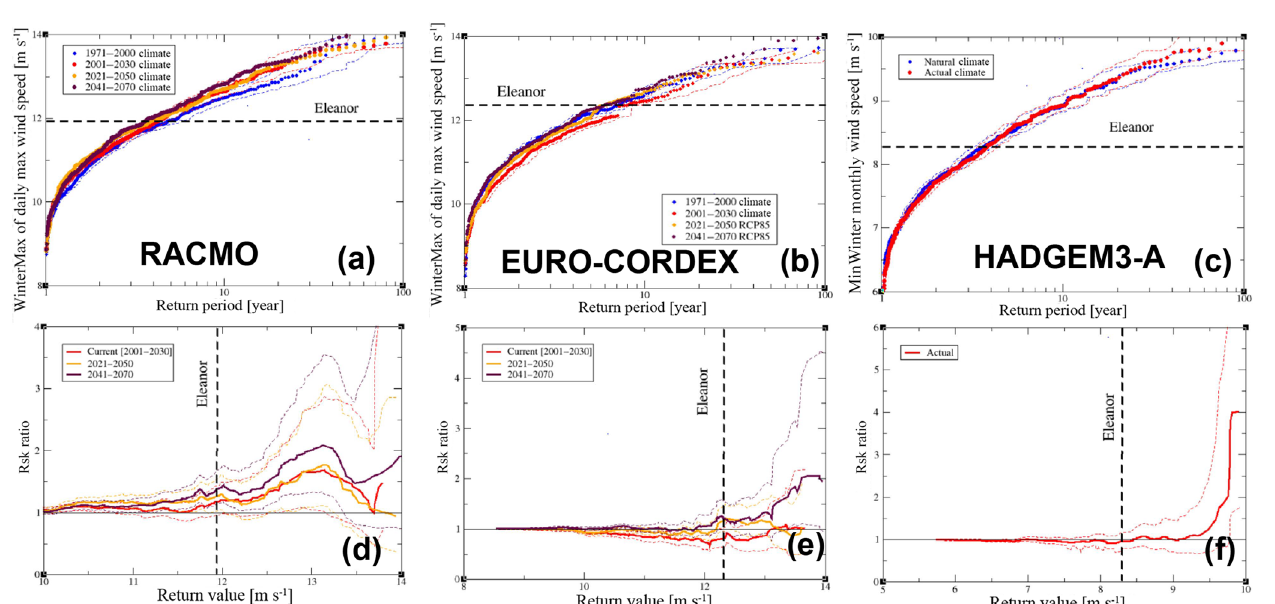
Figure 8. Same as Fig. 5 for storm